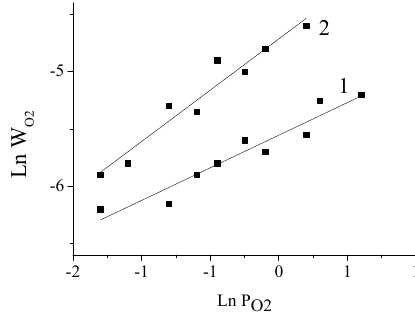
Figure 2. Logarithmic plots of oxygen consumption rate versus oxygen pressure in oxidation of aspen wood at 110 °C. (1) [OH − ] = 0.003 M, reaction order in O 2 0.56 ± 0.04. (2) [OH − ] = 2 M, reaction order in O 2 0.99 ± 0.10 (see references [44,67]).